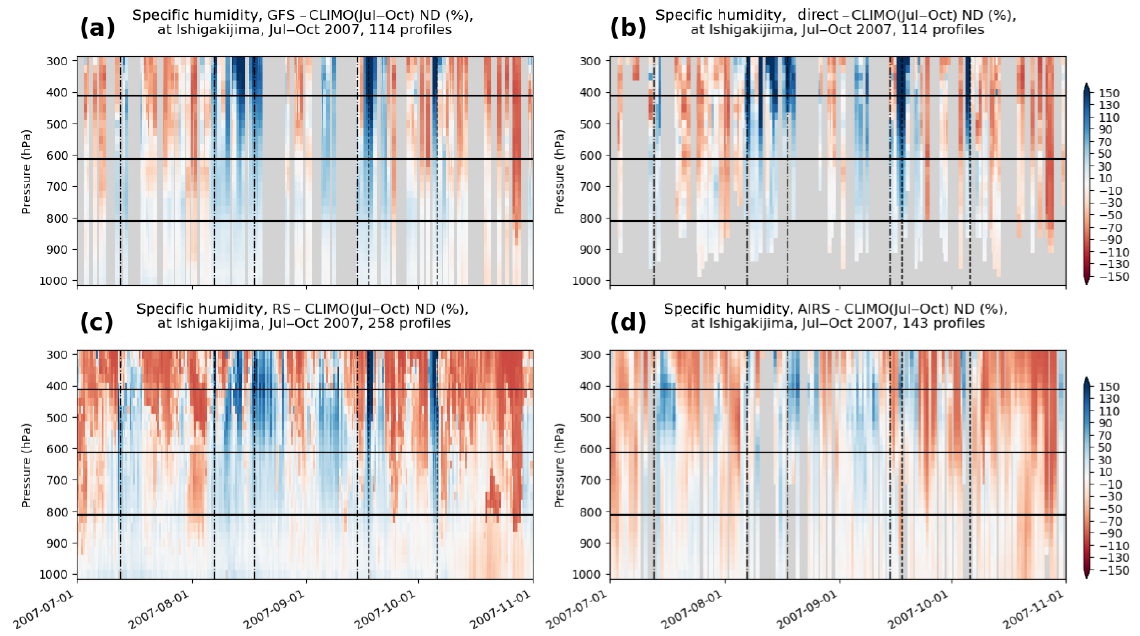
Figure 9. The q difference from CLIMO JulOct for (a) GFS, (b) UCAR direct, (c) RS, and (d) AIRS shows increased humidity during typhoon passages near Ishigakijima. Typhoon passages are marked by vertical lines (dashed: closer than 110km; dash-dotted: closer than